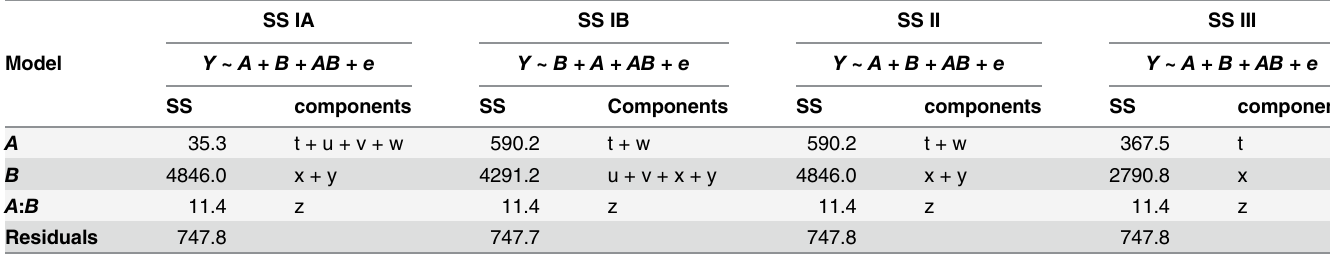
Table 2. The SS of example data, using (0, 1) coding for